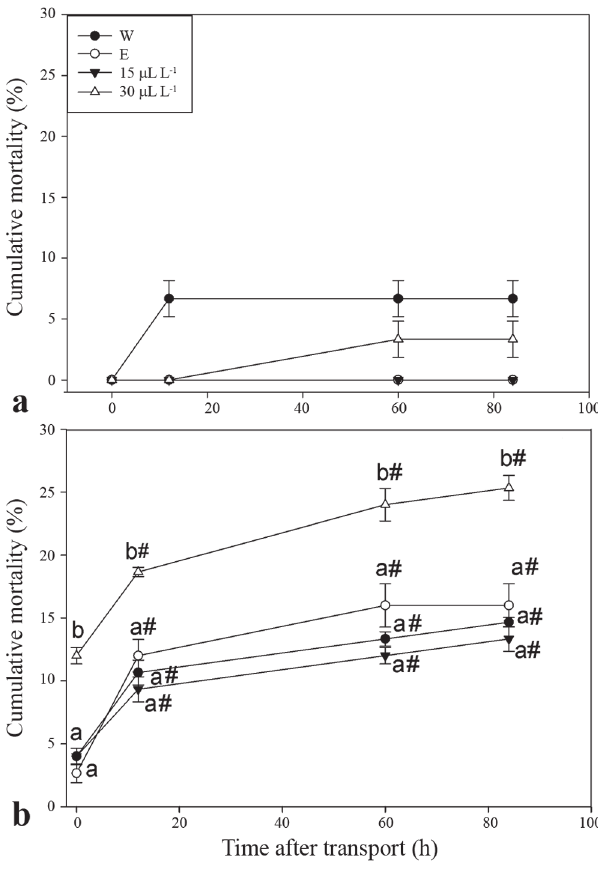
Fig. 1. Mortality after transport of fat snook Centropomus parallelus in plastic bags with essential oil from old leaves of Nectandra megapotamica (15 or 30 µL L -1 ) or ethanol (E) added to the water. W: control with only water. Data presented as means ± SEM ( n = 3). a , freshwater - no significant difference between groups or times was observed and the treatments E and 15µL L -1 are superimposed on the first line ; b , seawater - values with different superscripts are significantly different (P < 0.05). # Significant difference from arrival (0